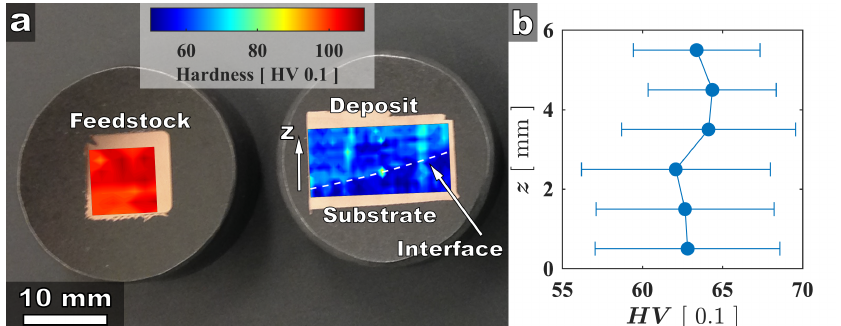
Figure 7. ( a ) Vickers hardness maps for the feedstock and the deposit (overlays are approximate). The maps are colored according to the same color-scale, shown above. The coordinate axis, z , defining the distance from the interface, is also marked; ( b ) variation in hardness of the deposit with respect to distance from the interface, z . The error bars represent standard